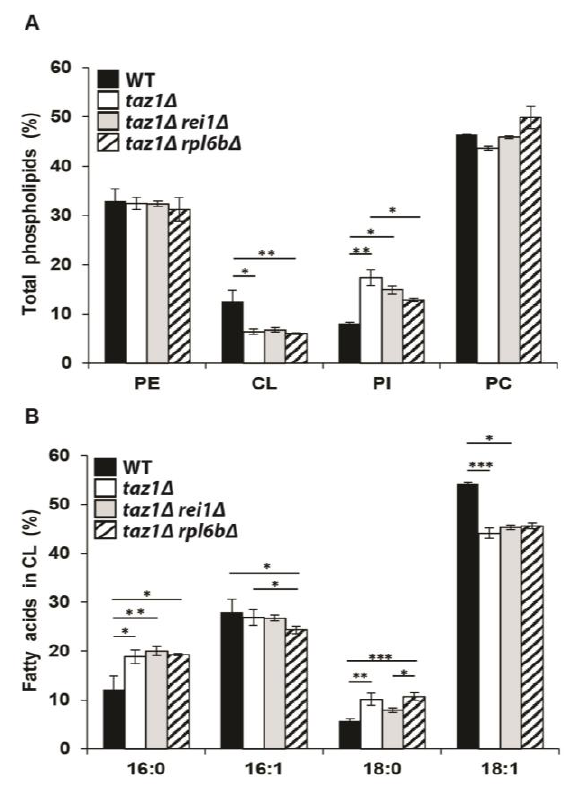
FIGURE 2: Genetic ablation of REI1 or RPL6B in taz1 Δ yeast does not restore cardiolipin remodeling. Lipids were extracted from mitochondria isolated from WT (black bars), taz1 Δ (open bars), taz1 Δ rei1 Δ (grey bars) and taz1 Δ rpl6b Δ (striped bars) cells grown in CSM 0.5% galactose + 2% ethanol at 36°C until a density of 2-3 OD 600nm . (A) Relative contents of PE (phosphatidylethanolamine), CL (cardiolipin), PI (phosphatidylinositol) and PC (phosphatidylcho- line) within each strain. (B) Relative fatty acid chain composition of CL within each strain (16:0, palmitic acid; 16:1, palmitoleic acid; 18:0, stearic acid; 18:1: oleic acid). Statistical analysis was done with Kruskal-Wallis test followed by Dunn’s multiple comparison test (*P<0.05; **P<0.01; ***P<0.001). Data are expressed as mean ± s.d. (n=4). The data for WT and taz1 Δ strains were report- ed previously [60]